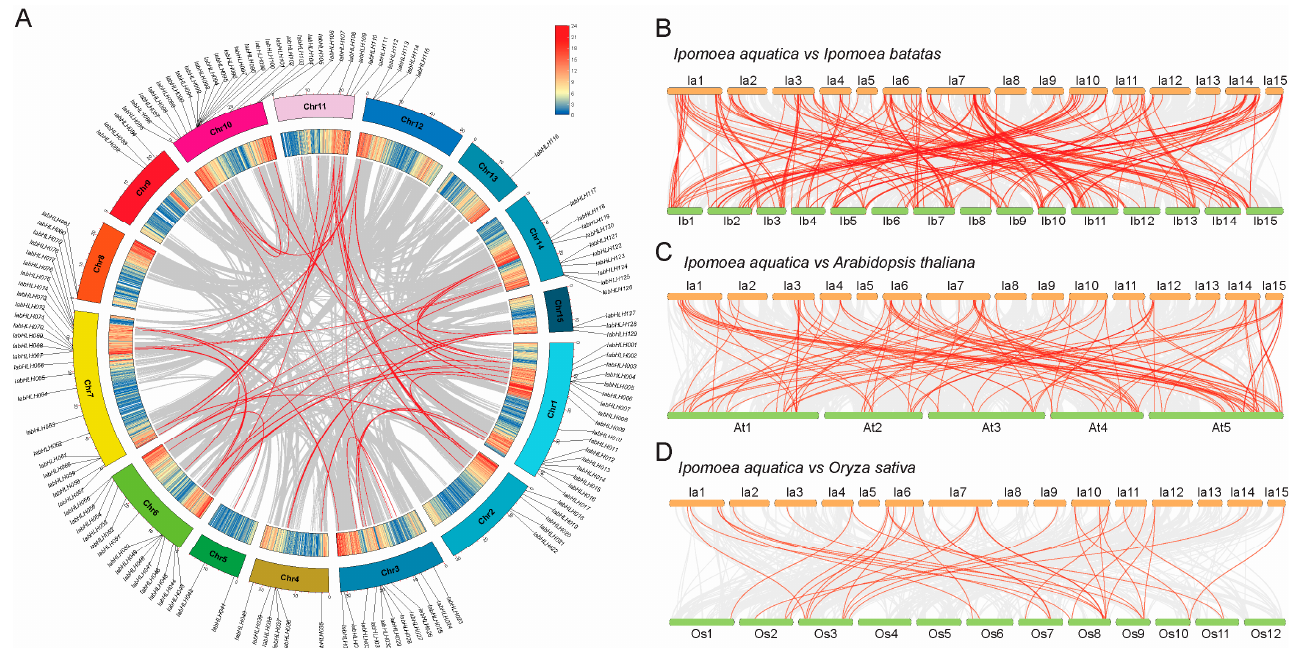
Figure 2. Analysis of IabHLH genes at the chromosome level. ( A ) Chromosomal location of the IabHLH genes. The gene pairs linked by red lines were the 44 IabHLH collinear gene pairs located on chromosomes; the outer circle represents 15 chromosomes of I. aquatica , while the inner circle indicates the gene density of each chromosome. ( B – D ) Syntenic relationships between IabHLH genes and the other plant species’ genome. The gray lines among chromosomes indicate all homologous gene pairs at the whole-genome level, while the red lines among chromosomes show homologous gene pairs related to the IabHLH genes. More information concerning the homologous gene pairs was shown in Table S3.